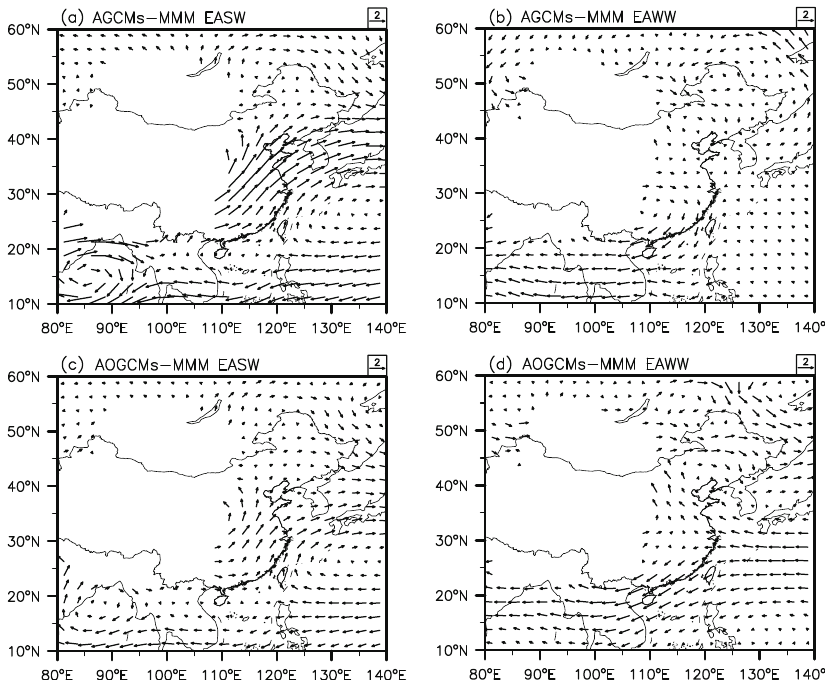
Fig. 5. The MMM for EASW (left column, units: ms − 1 ) and EAWW differences (right column, units: ms − 1 ) between mid-Pliocene and pre-industrial experiments. (a) and (b) are the AGCMs-MMM; (c) and (d) are the AOGCMs-MMM. Regions with an elevation above 1500m are left